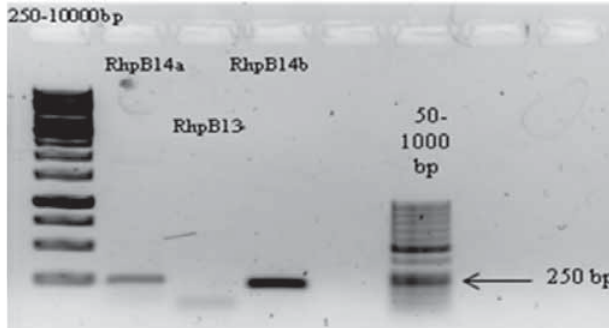
Figure 4. Test PCR with the designed primers at 53°C. The amplification with RhpB14b was satisfactory, but the other two needed to be optimised